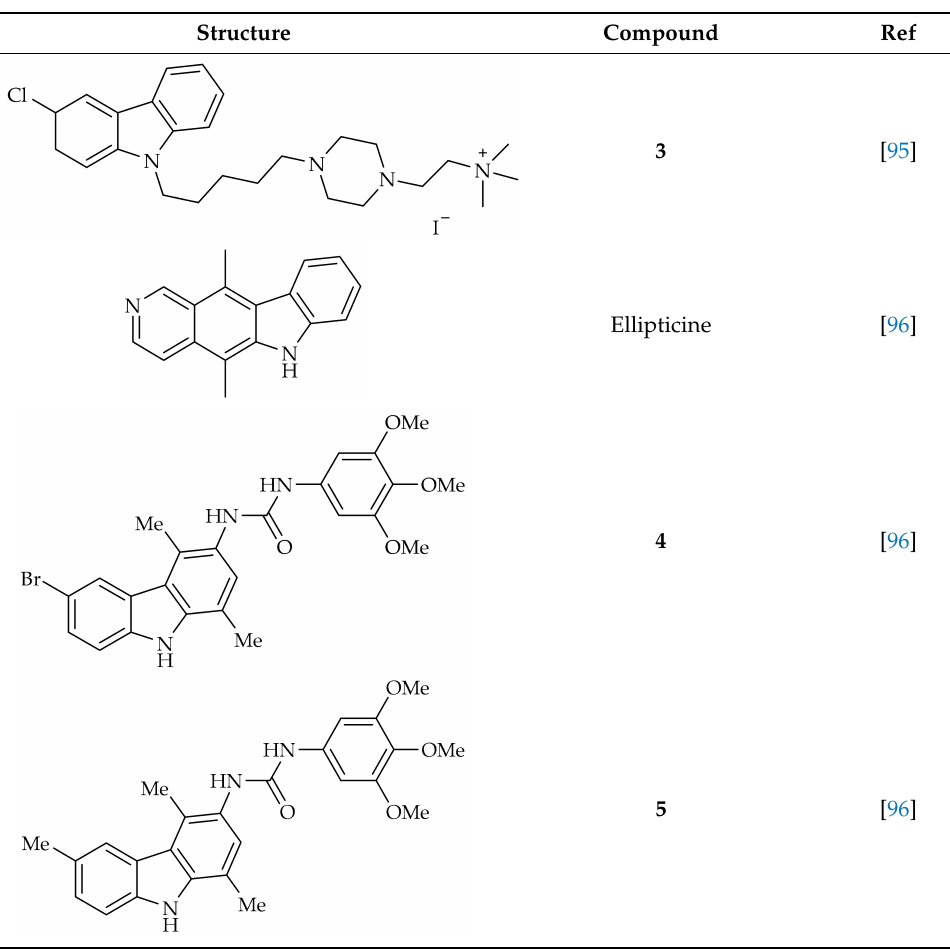
Table 2. Structure of carbazole derivatives or bioisosters studied for the treatment of